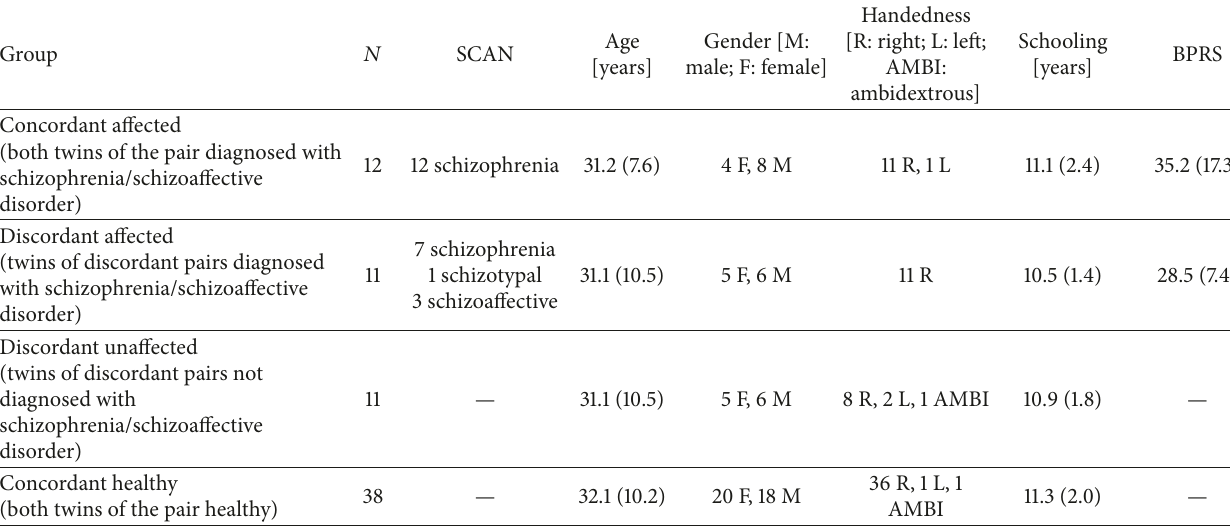
Table 1: Clinical characteristics: mean values (standard deviation).